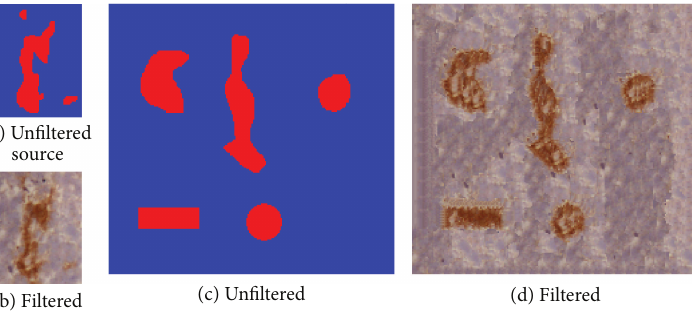
Figure 6: Synthetic vascular image. The unfiltered source image (a) was outlined manually to annotate (b). We created the unfiltered target image (c); then the filter learned from (a) and (b) was applied to (c) to get (d). The result is shown in